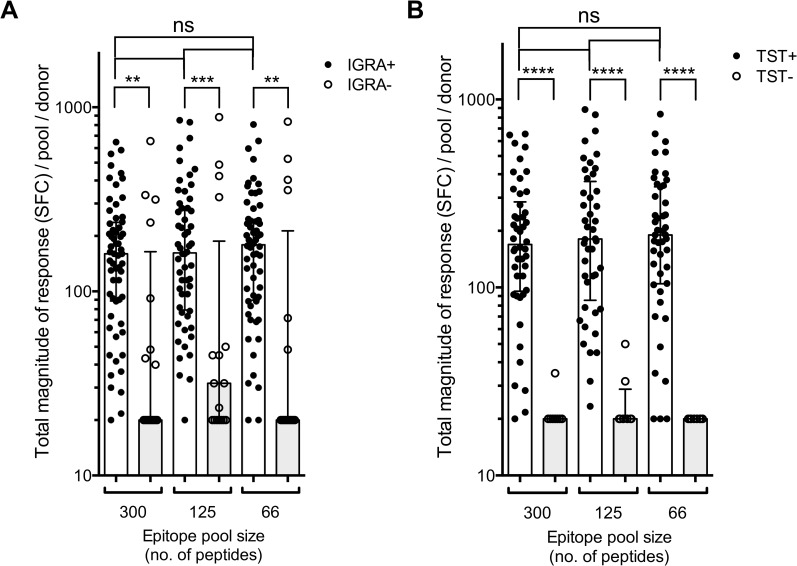
General applicability of peptide pools to detect responses in other cohorts.(A) Magnitude of epitope pool (megapool) responses in a validation cohort of individuals with LTBI, and an IGRA-negative control cohort. Each dot represents one donor (n = 60, IGRA+, black dots and n = 17, IGRA-, open circles) median ± interquartile range is indicated. Two-tailed Mann-Whitney test, ns; no significant difference, **, p<0.01, ***, p<0.001. (B) Magnitude of megapool responses in individuals in the validation and negative control groups stratified by TST status. Each dot represents one donor (n = 46, TST+, black dots and n = 8, TST-, open circles) and median ± interquartile range is indicated. Two-tailed Mann-Whitney test, ns; no significant difference, ****, p<0.0001.